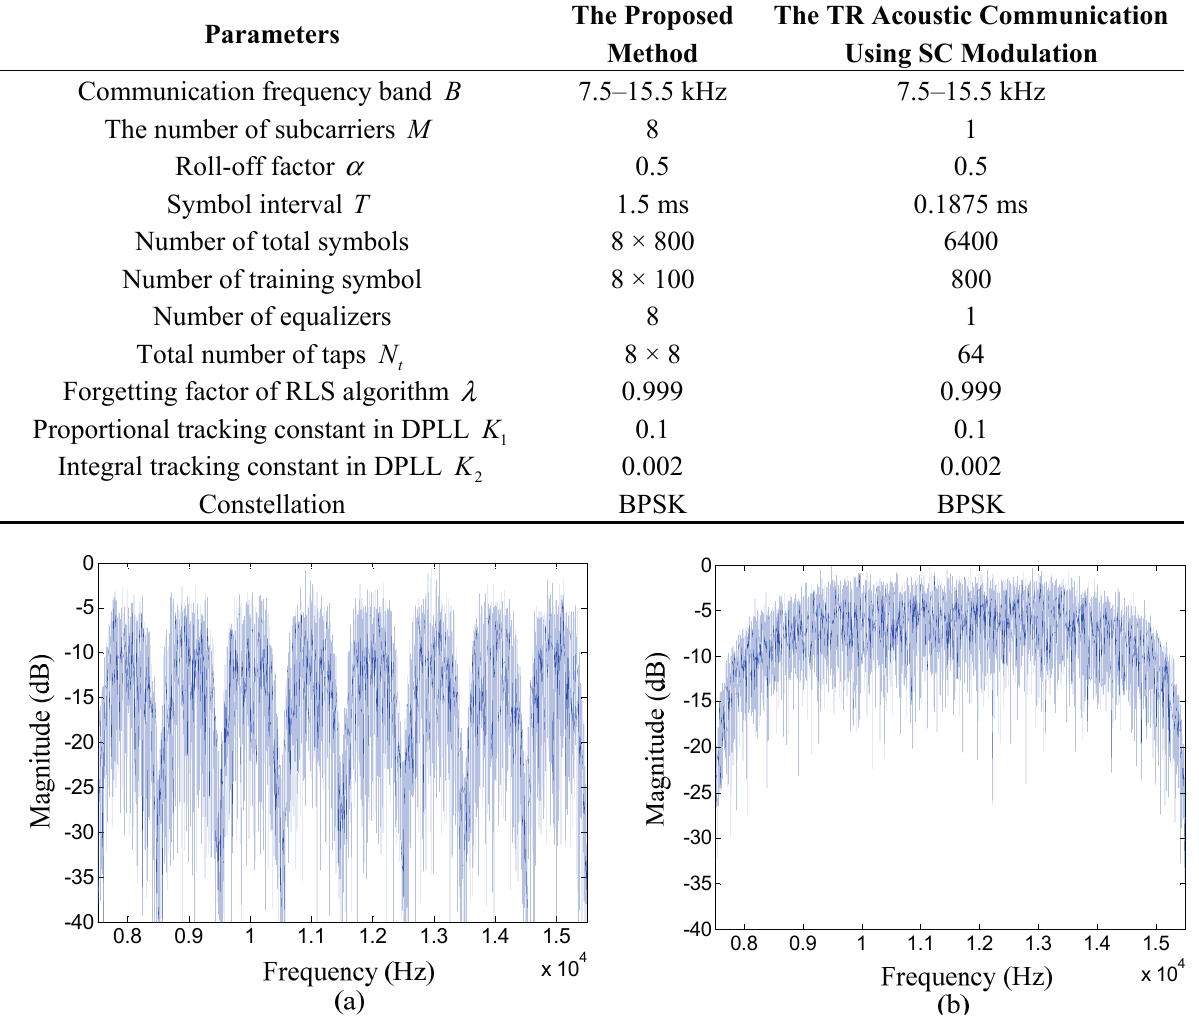
Table 1. Parameters for two communication methods in the experiment.